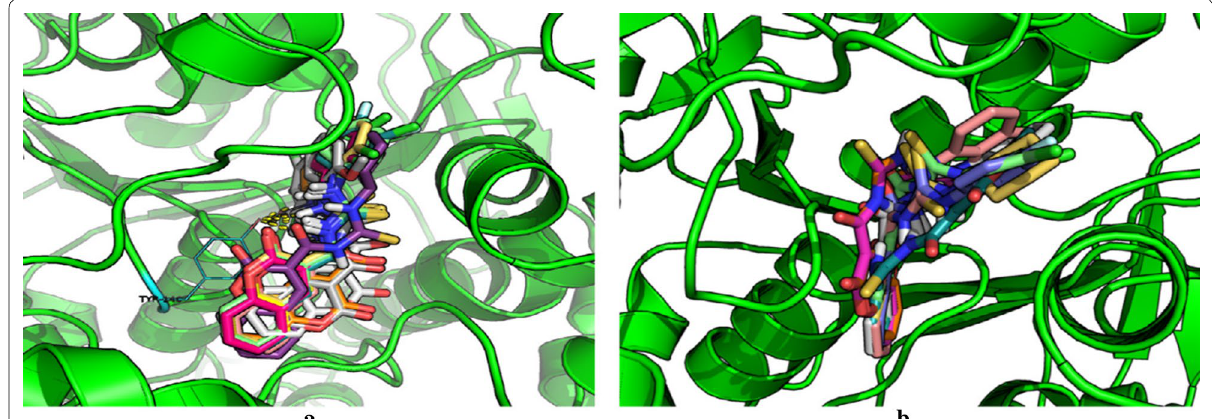
Fig. 29 a , b Binding models of the synthesized compounds in AChE and BuChE enzymes active sites. Yellow dashed lines in ( a ) showing hydrogen bonding between Tyr146 and one of thioureas hydrogen atom from different compounds